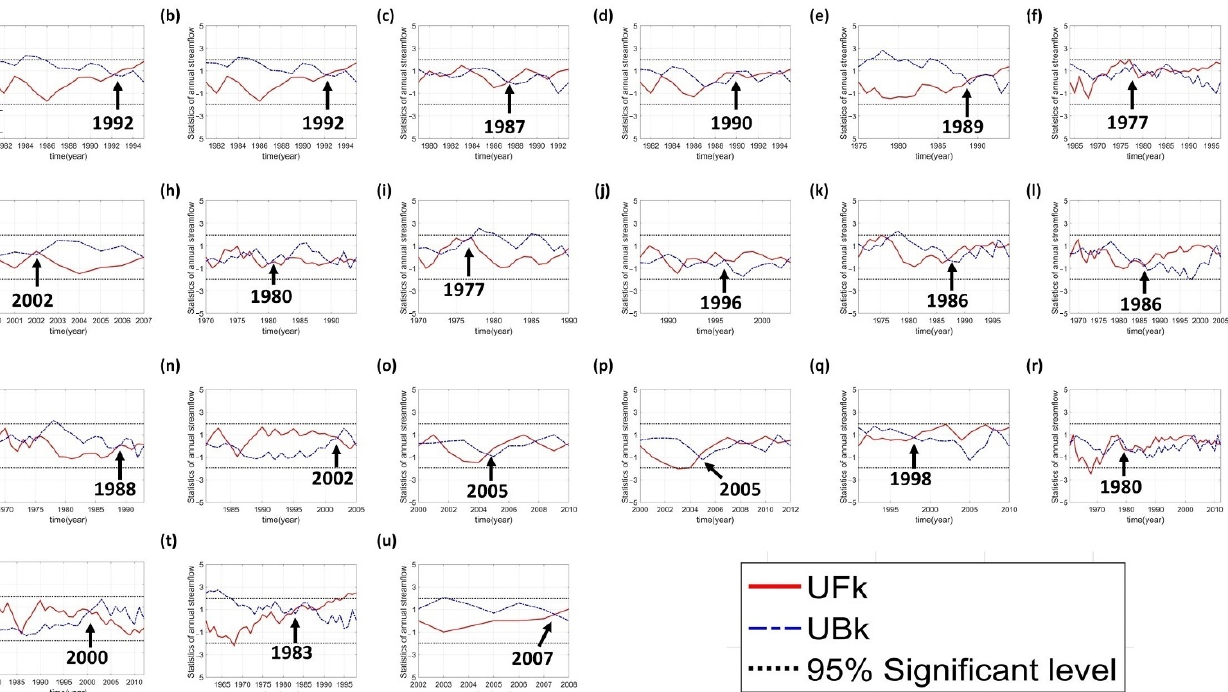
Figure 8. Correspondence between NSE and Pbais values of CM model at different watershed areas.